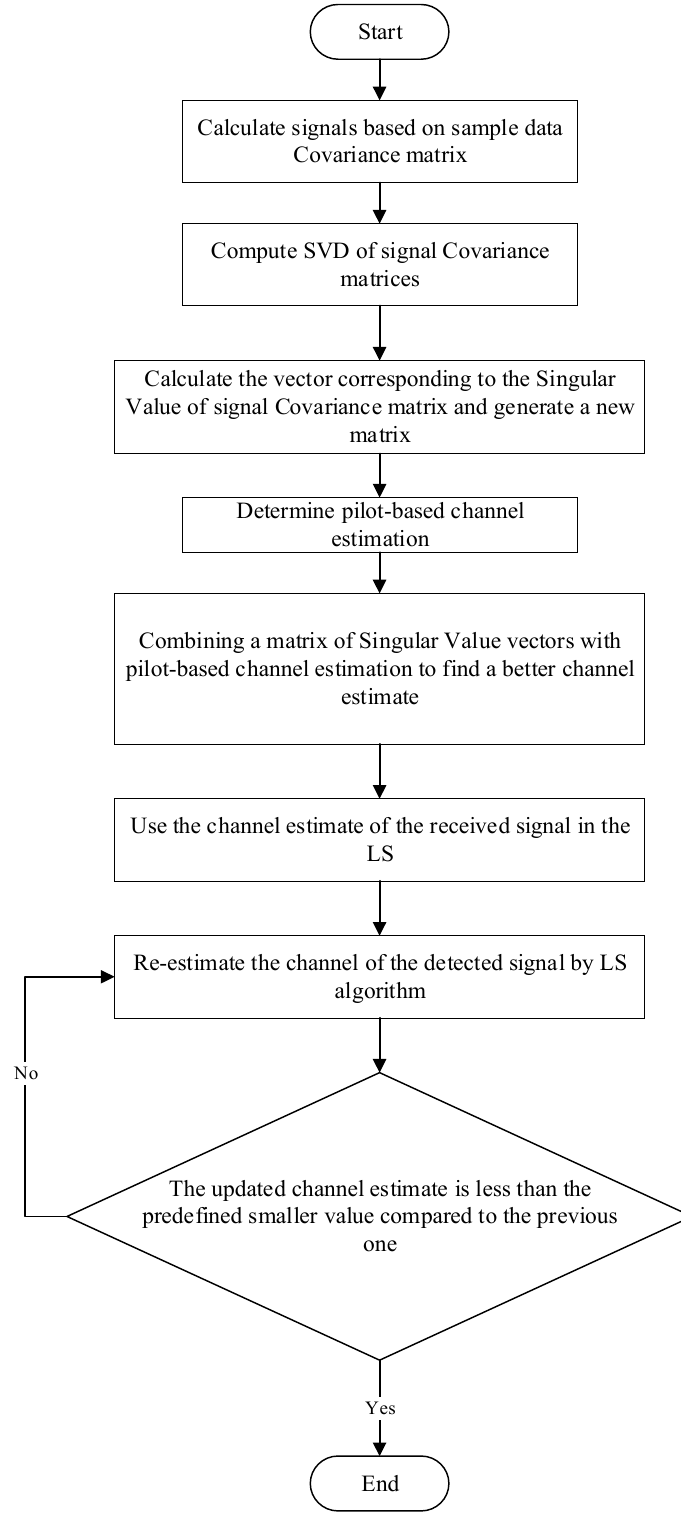
Figure 2. Improved Singular Value Decomposition (SVD) algorithm processing flow.